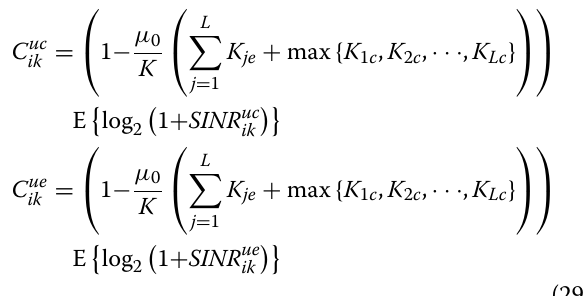
with M = 256 and K = 10. It is evident that as the shadowing fading increases, the target cell’s achievable sum rate of conventional schemes declines continuously.